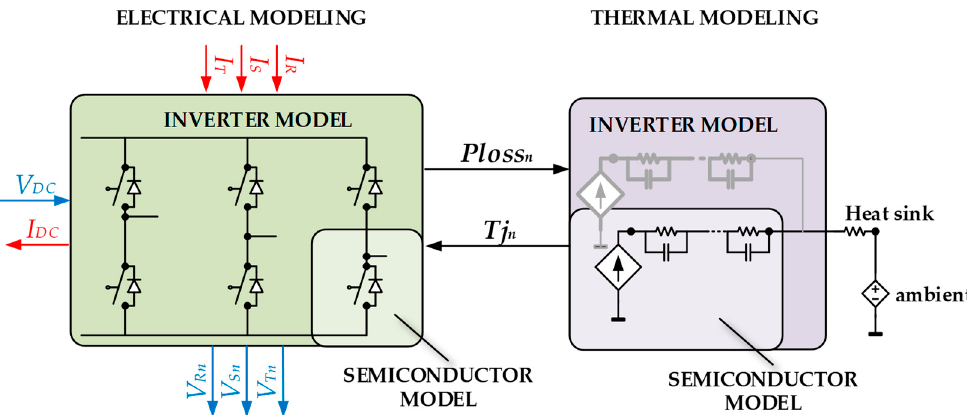
Figure 3. Electro-thermal model coupling represented by the electrical and thermal model. V DC and I DC are the DC bus voltage and current, V Rn , V Sn , and V Tn and I R , I S and I T are the AC side voltages and currents, Ploss n and Tj n are the semiconductors (diodes and switches) power losses and junction temperature, respectively.